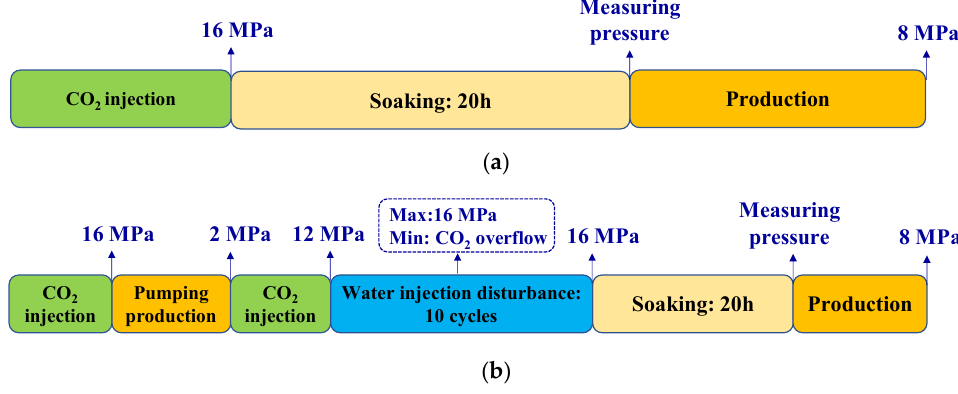
Figure 3. Experimental scenario design: ( a ) case 1: CO 2 huff and puff; ( b ) case 2: CO 2 huff and puff assisted by pumping production and water injection disturbance.